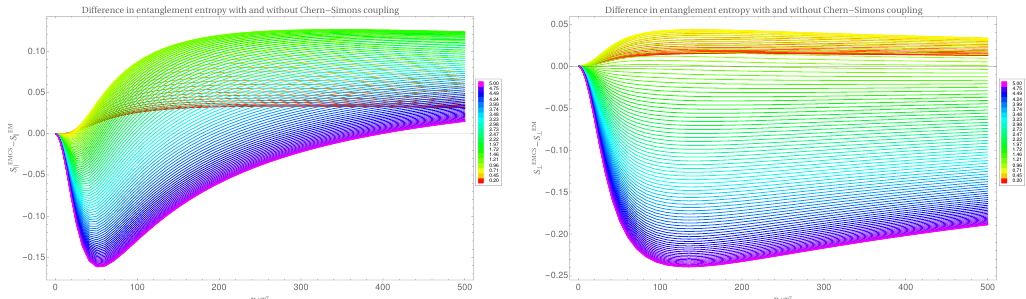
Figure 8 . Numerical replication of figure 1. Left: the deviation of the EMCS charged magnetic black brane metric component g x from its near horizon behavior, with magnetic field from 1 x 1 B/T 2 = 1 . 00 shown in red to 500 . 00 in blue at µ/T = 5 and γ = γ SUSY . Right: solutions for the embedding coordinates ( x 1 ( σ ) , z ( σ )) . These curves have been computed for µ/T = 5 , γ = γ SUSY , and B/T 2 = 1 for lengths ‘ = 2 / 10 in red to ‘ = 5 in purple.